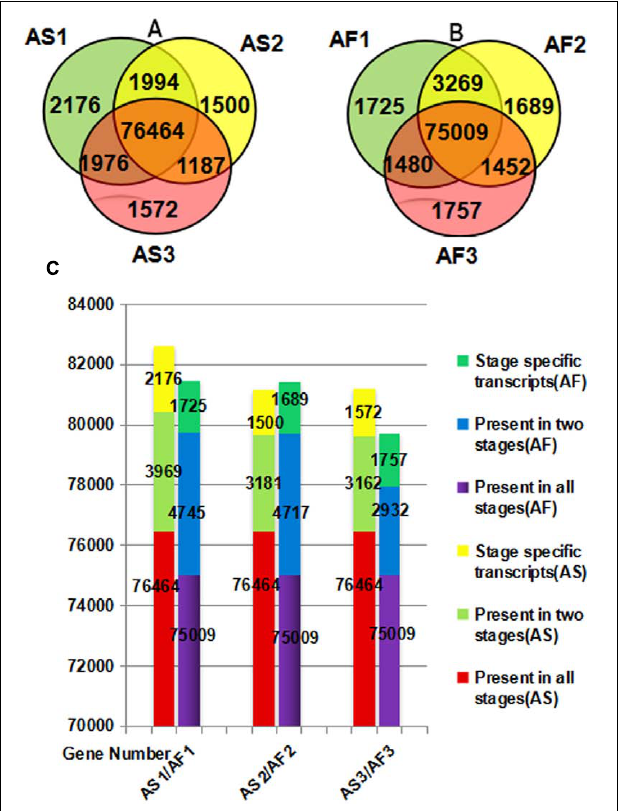
FIGURE 4 | Venn diagram (A,B) and accumulation histogram (C) comparing the differentially expressed genes (DEGs) in AS and AF. The numbers of DEGs are shown in the different segments. (A) Total DEG genes in AS. (B) Total DEG genes in AF. (C) Accumulation histogram showing the transcriptome sizes during the three stages for AS and AF, as well as the changes in the numbers of transcribed genes during anther development in AS and AF. The horizontal axis indicates different samples and the vertical axis represents the number of